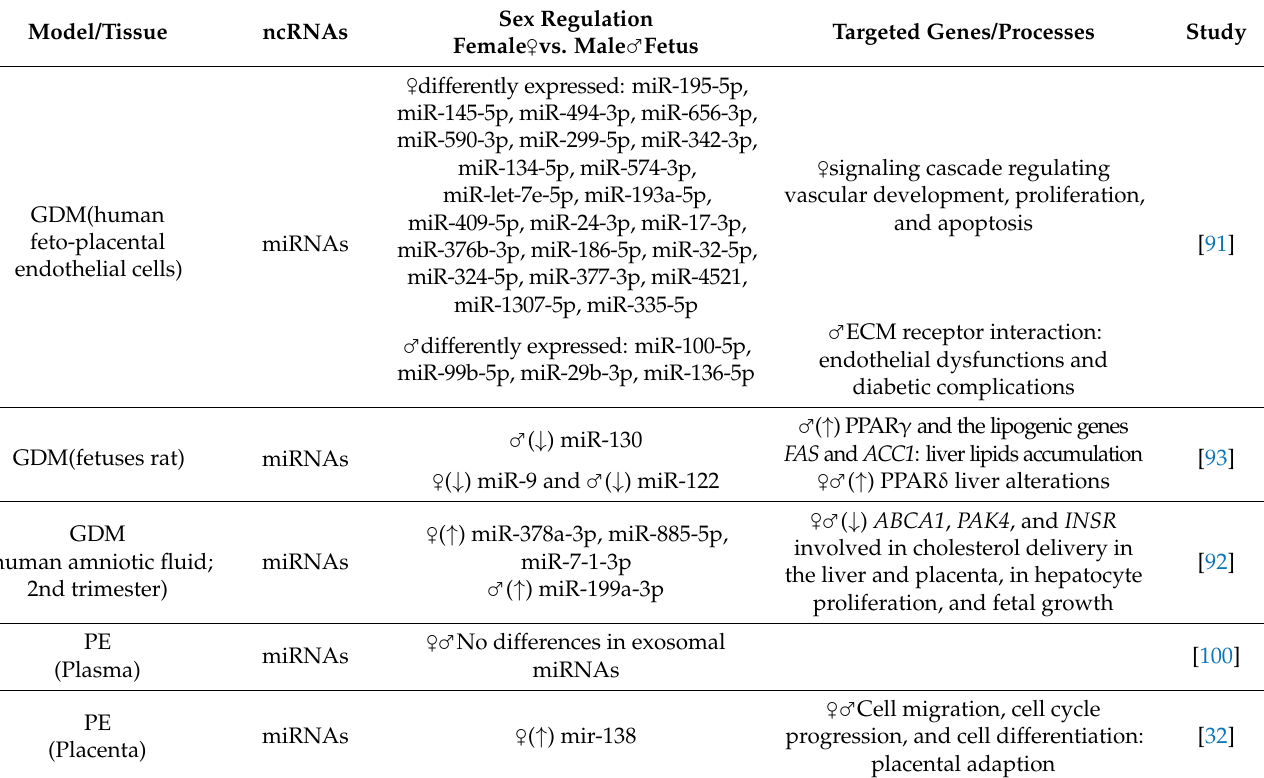
Table 3. Fetal sex-specific ncRNAs expression in pregnancy